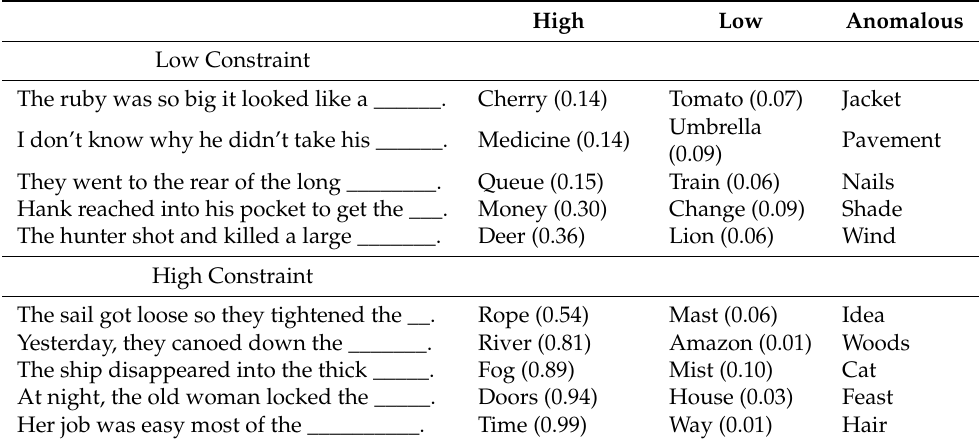
Table 1. Example stimuli, with the three types of continuation. Cloze probability in parentheses from Arcuri et al. [60].